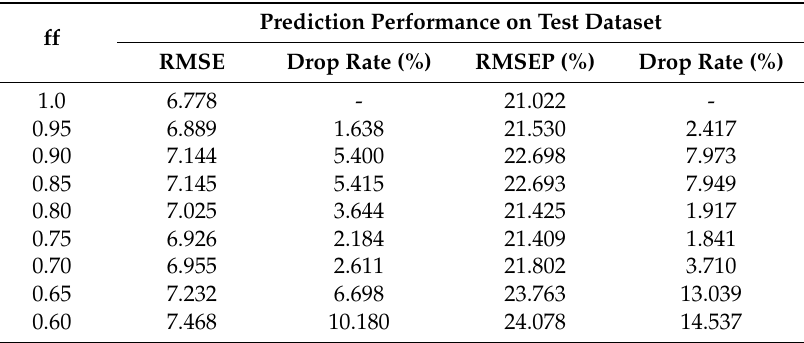
Table 5. Performance of the CRS-ConvLSTM under different extracting rate.